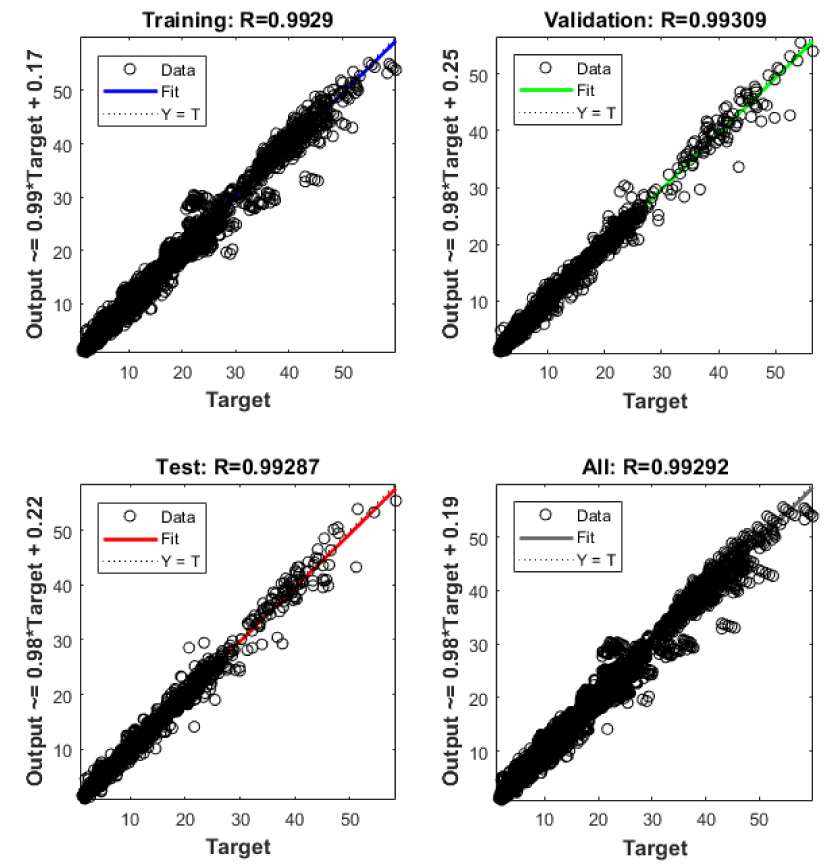
Figure 5. Regression results of training, validation, and test results of neural network.